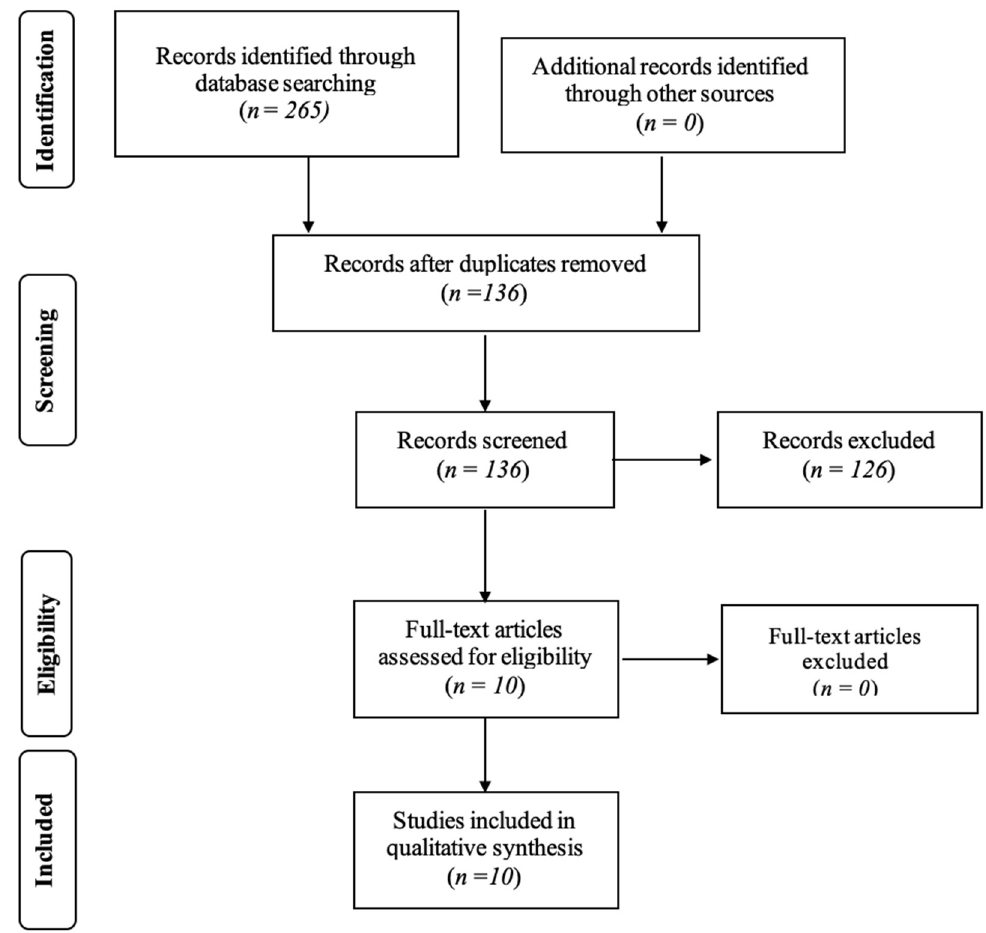
Figure 1. Article screening: four-phase PRISMA (preferred reporting items for systematic reviews and meta-analyses) flow diagram for study collection, showing the number of studies identified, screened, deemed eligible, and included in the present review. Table 2. Characteristics and main data of the reviewed studies, extracted according to the PICOS approach. Part